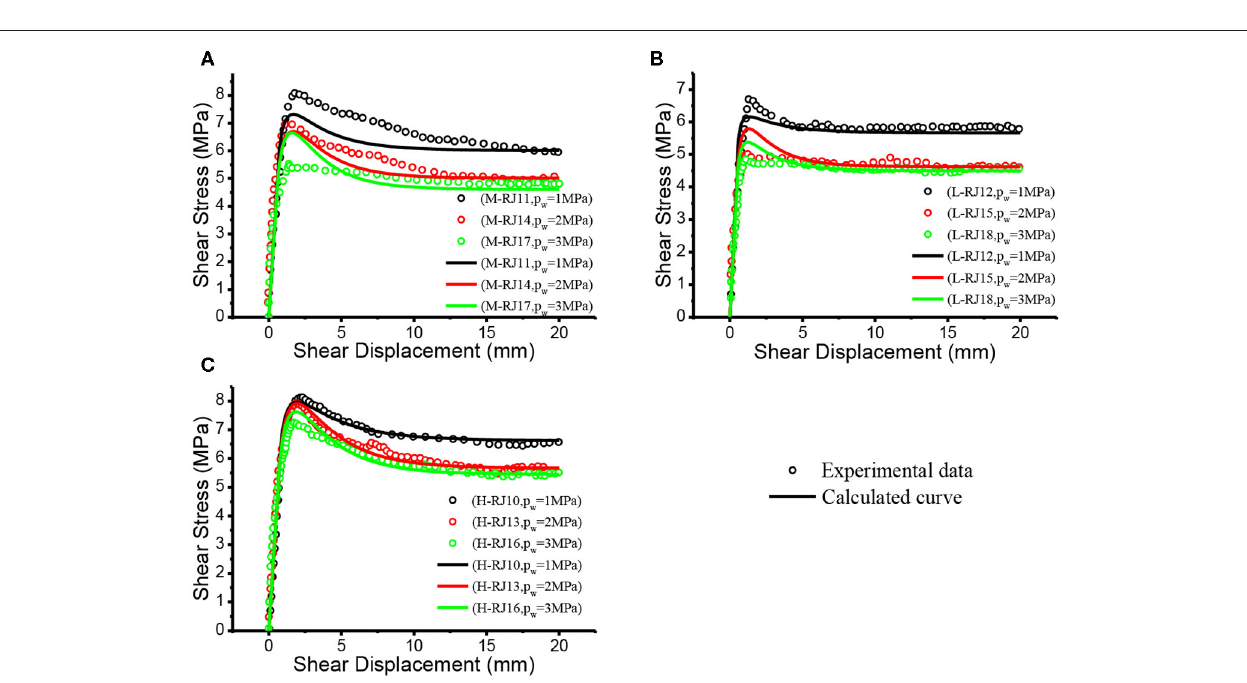
FIGURE 7 | Comparison between the calculated curve of proposed model and experimental result ( σ n = 8 MP a). (A) M joint (B) L joint (C) H joint.